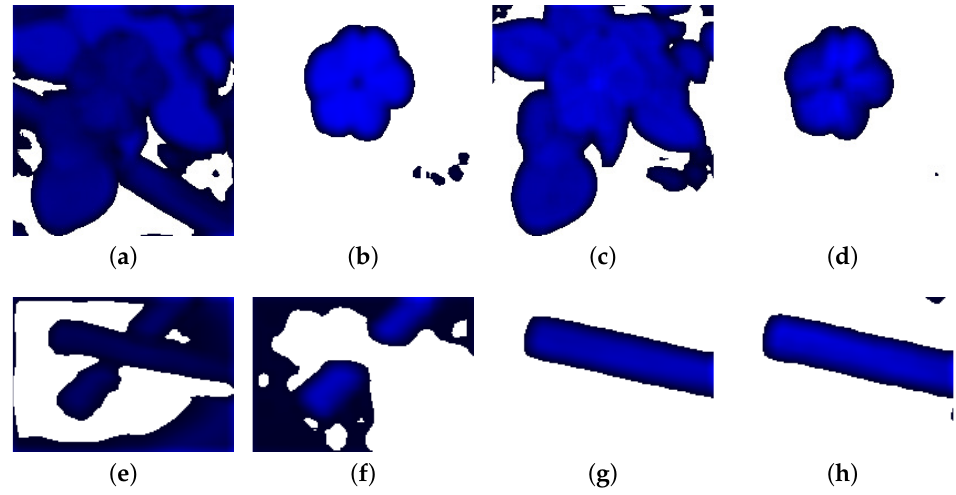
Figure 14. The comparison of RMS values between our method and Kuhn’s method. ( a ) The RMS value between Figures 6a and 12a. ( b ) The RMS value between Figure 12b and 12a. ( c ) The RMS value between Figures 6a and 12c. ( d ) The RMS value between Figure 12d and 12c. ( e ) The RMS value between Figure 13a and 13b. ( f ) The RMS value between Figure 13c and 13b. ( g ) The RMS value between Figure 13a and 13d. ( h ) The RMS value between Figure 13e and